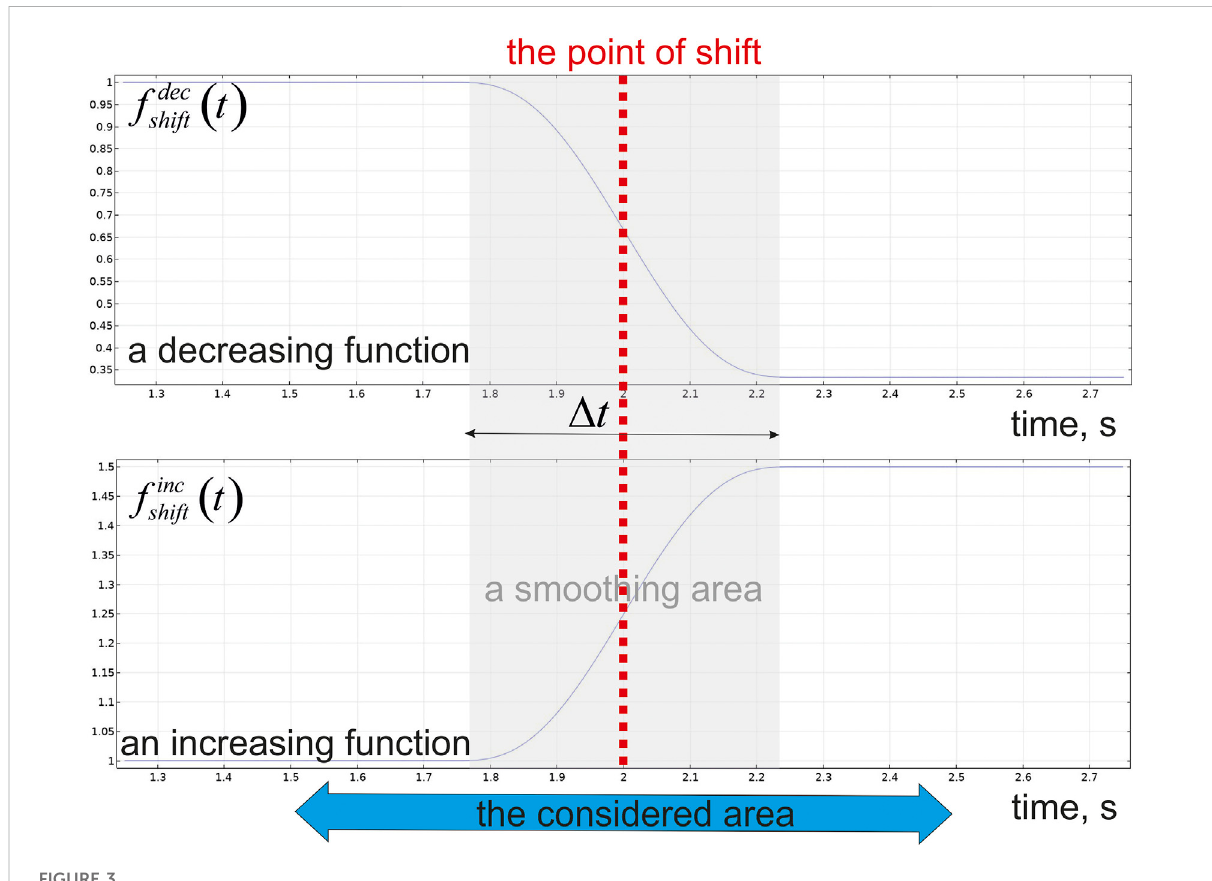
FIGURE 3 The step-like function governing inlet/outlet pressure in a capillary blood fl